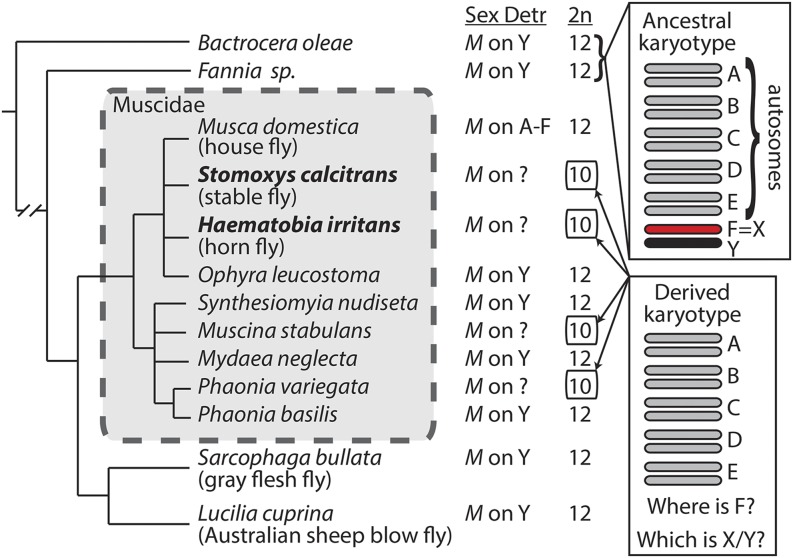
Cryptic sex chromosomes in Muscidae. Phylogenetic relationships and karyotypes of muscid flies and their relatives (Boyes et al. 1964; Boyes and Van Brink 1965; Schnell e Schuehli et al. 2007; Vicoso and Bachtrog 2015). The inferred mechanism of sex determination (Sex Detr) and the diploid chromosome number (2n) are listed for each species. “M” refers to a generic male-determining locus.